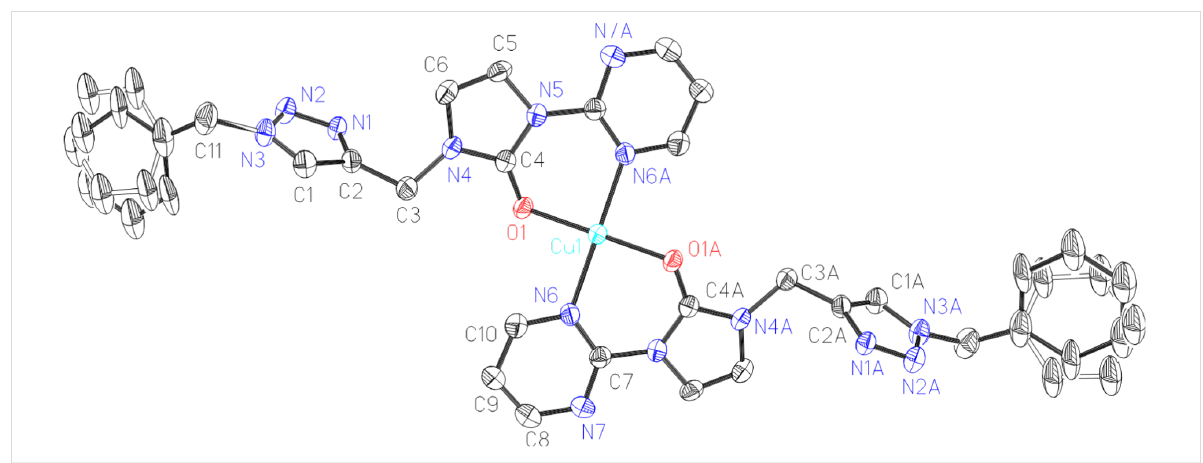
Figure 1: X-ray diffraction structure of copper(II) complex 2 with thermal ellipsoids drawn at 30% probability. The anion and hydrogen atoms are omitted for clarity. Selected bond distances (Å) and angles (°): Cu1-O1 1.931(4), Cu1-N6 2.042(5); O1-Cu1-O1A 180.0(3), O1-Cu1-N6A 90.5(2), O1-Cu1-N6 89.5(2), N6-Cu1-N6A 180.00(8). Symmetry transformations used to generate equivalent atoms: − X, Y, 0.5 − Z.